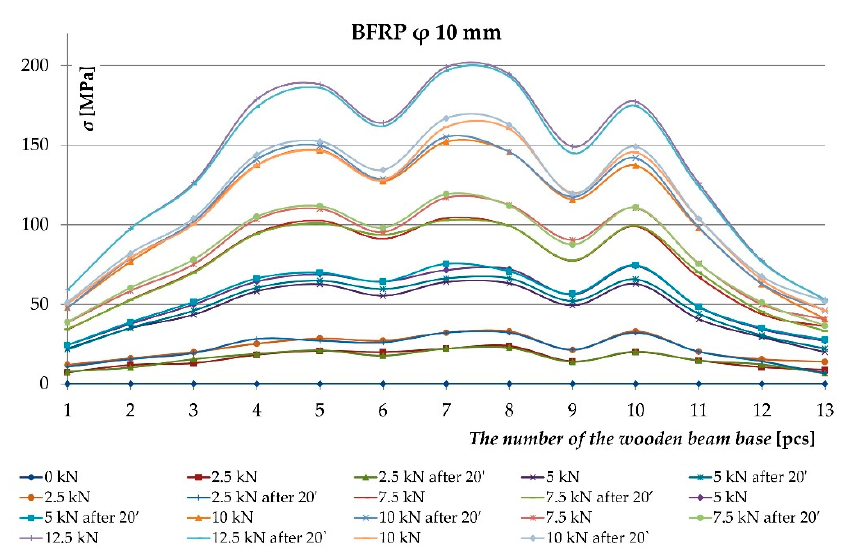
Figure 9. Distribution of normal stresses in the BFRP rod σ [MPa] along the entire length of the Wa-A1 reinforced beam.